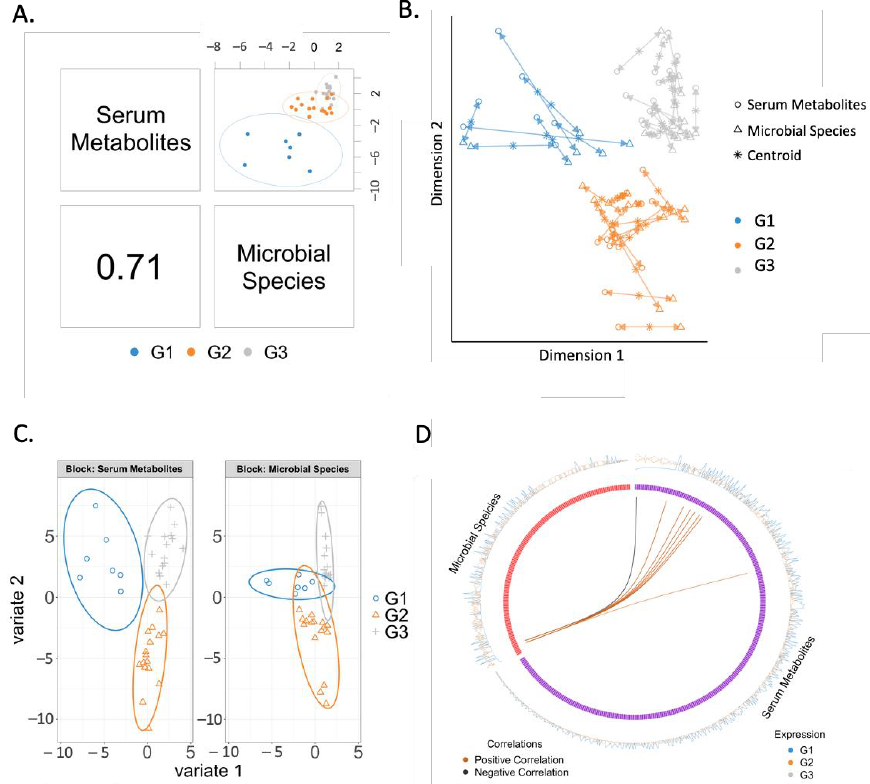
Figure 3. Correlated serum metabolites and microbial species. ( A ) The overall correlation between serum metabolites and microbial species is 0.71. ( B ) Similarities (points are clustered) and dissimi- larities between samples and groups. Samples are represented as points placed according to their projection in the smaller subspace spanned by microbial species and serum metabolites. ( C ) Agree- ment between microbial species and serum metabolites. Each arrow corresponds to one sample. The start of the arrow indicates the location of the sample in the microbial species plot, and the tip is the location of the sample in the serum metabolites plot. Short arrows indicate if both data sets strongly agree, and long arrows indicate a disagreement between two data sets. ( D ) Correlations between variables of serum metabolites and microbial species. Cut-off is set to 0.6. A black line indicates a negative correlation; an orange line indicates a positive correlation. G1: non-alcoholic control subjects; G2: patients with alcohol-associated non-progressive liver disease; G3: patients with alcohol-associated progressive liver